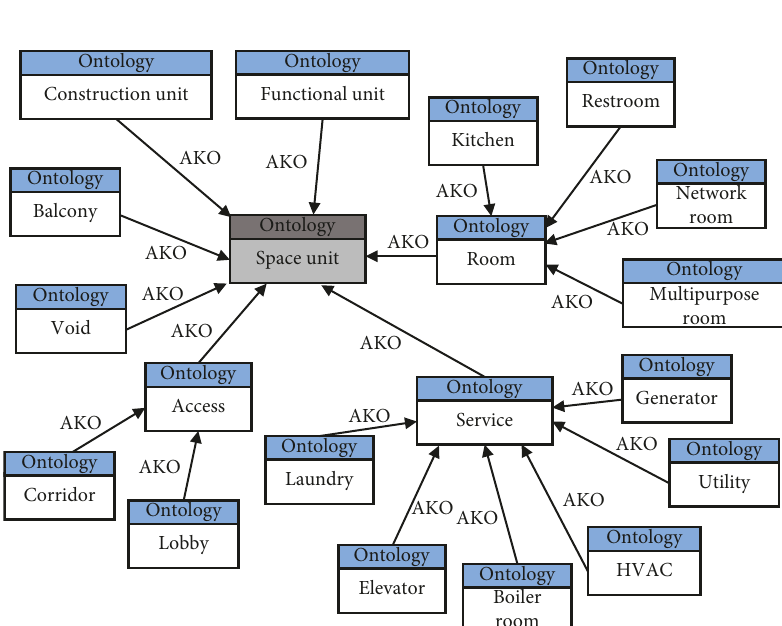
Figure 2: Building units (BUs).